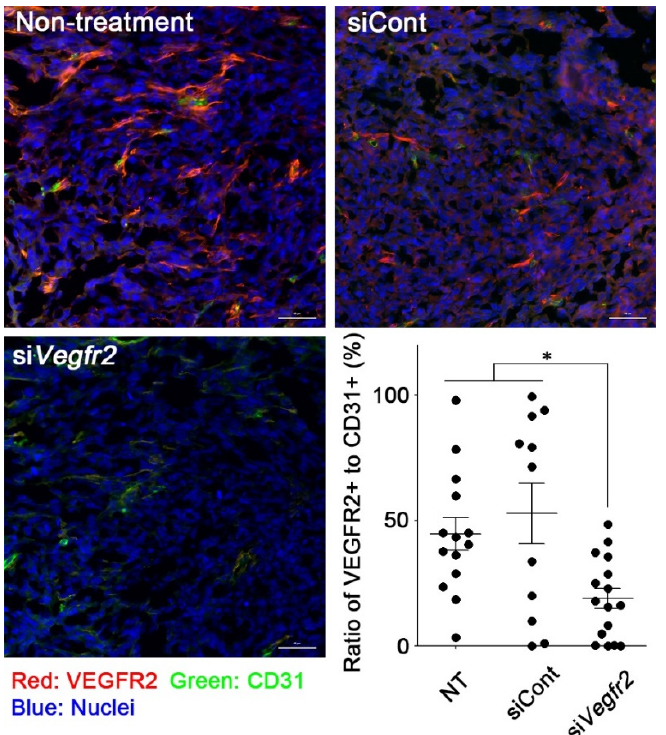
Figure 2. In vivo Vegfr2 knockdown in MC38 tumors by delivery of si Vegfr2 using RGD-LNP . MC38 tumor-bearing mice were administered with RGD-LNP encapsulating either si PLK1 as a control, or si Vegfr2 , at a dose of 40 μ g siRNA. Tumors were harvested 24 h after administration, sectioned, and stained as described in the Materials and Methods section. Four tumors from each group were imaged, and CD31-positive cells stained with VEGFR2 or not stained were quantified in each image. Red: VEGFR2, green: CD31 (marker of endothelial cells), blue: nuclei. * p < 0.05 determined using one-way ANOVA followed by Tukey’s test. Bars: 50 μ m.